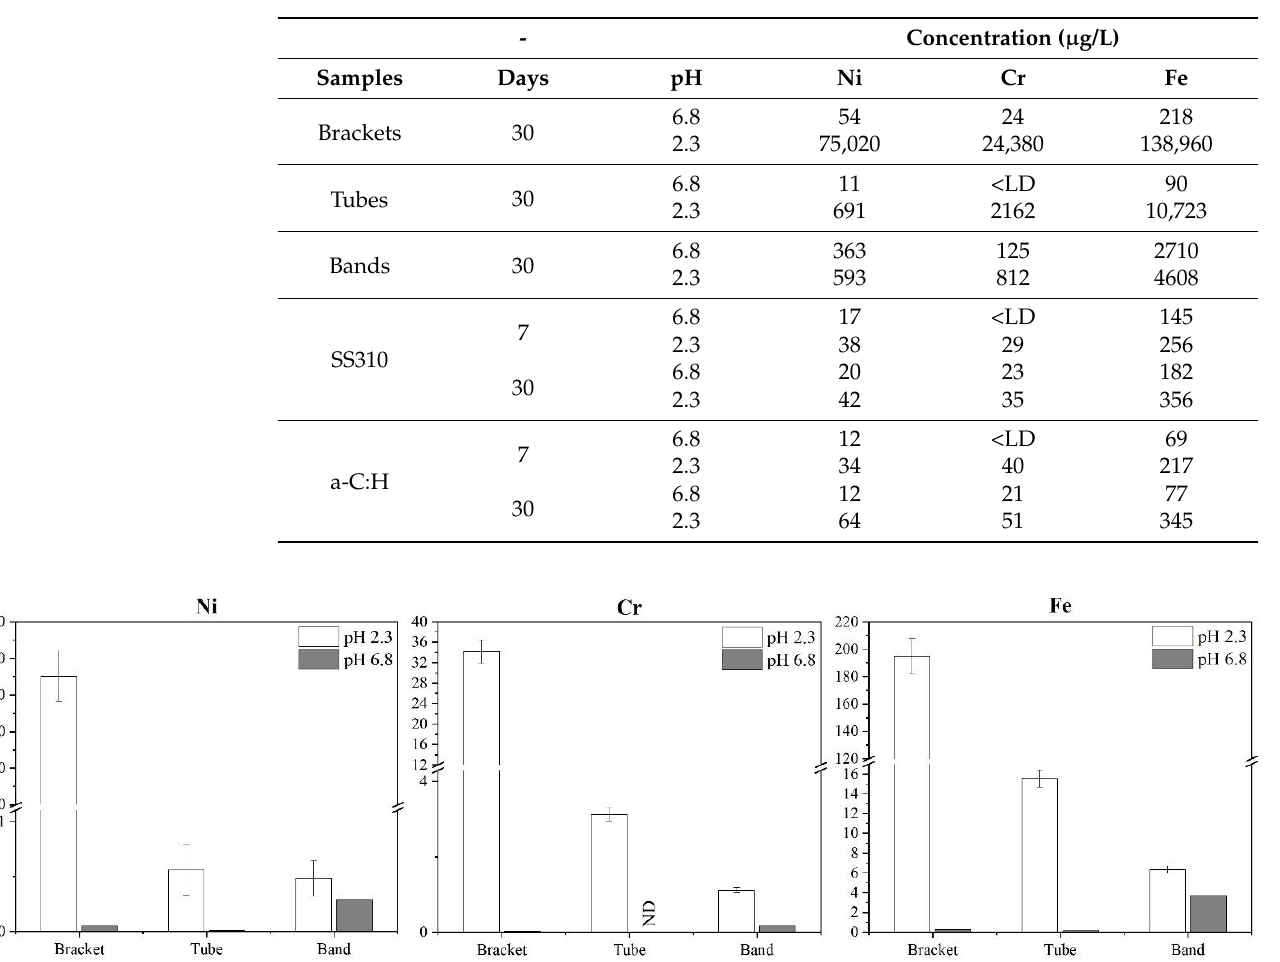
Table 3. ICP-OES data concerning Ni, Cr, and Fe release.